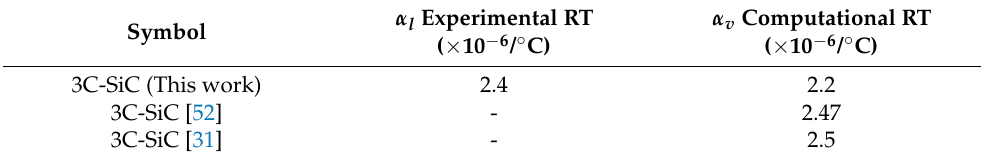
Table 3. Experimentally and computationally coefficients of thermal expansion of 3C-SiC.